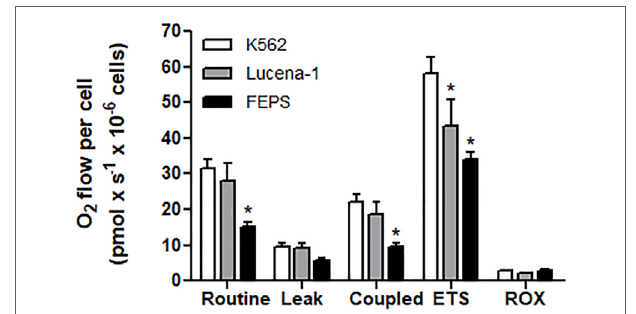
FiGUre 1 | High-resolution respirometry of K562, Lucena-1, and FEPS cells. Respiratory parameters of intact K562, Lucena-1, and FEPS cells. Routine respiration—basal respiration of intact cells; leak respiration—rate of oxygen consumption after the addition of oligomycin, that is, uncoupled respiration; coupled respiration (routine–leak); ETS—maximum respiratory capacity (induced by the addition of FCCP); ROX—rate of oxygen consumption in the presence of rotenone and antimycin A, that is, respiration not associated with electron transport system. All the parameters were corrected by ROX values. The bars marked with asterisks denote the values that are significantly different with reference to K562